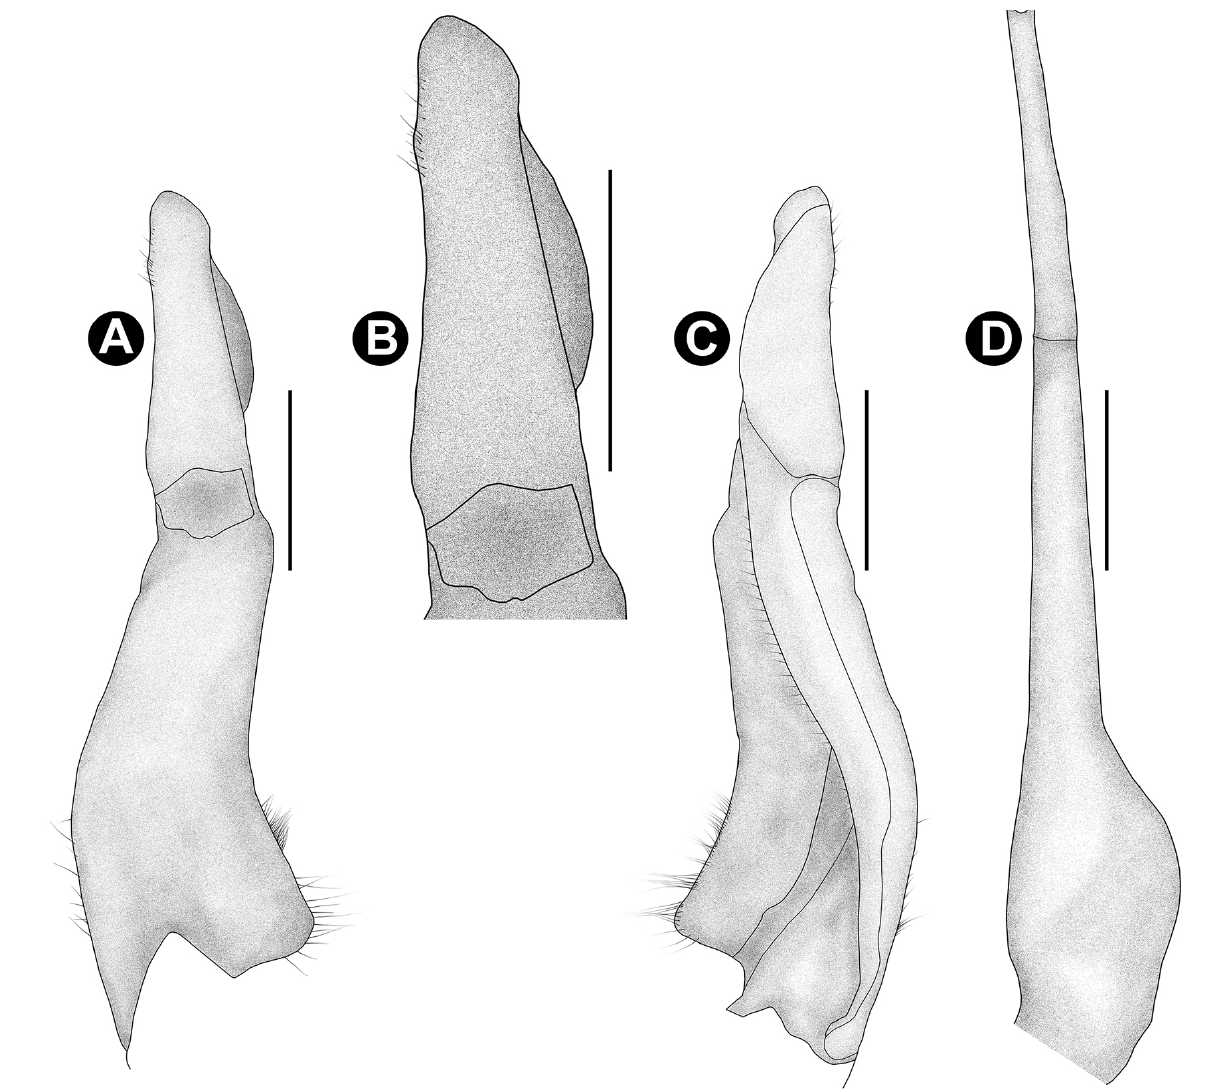
Figure 7. Abormon capillosum sp. nov., holotype male (10.2 × 8.5 mm) (ZSIK C.8610/2). A , dorsal view of left G1; B , dorsal view of left G1 terminal segment; C , ventral view of left G1; D , left G2. Scale bar = 1